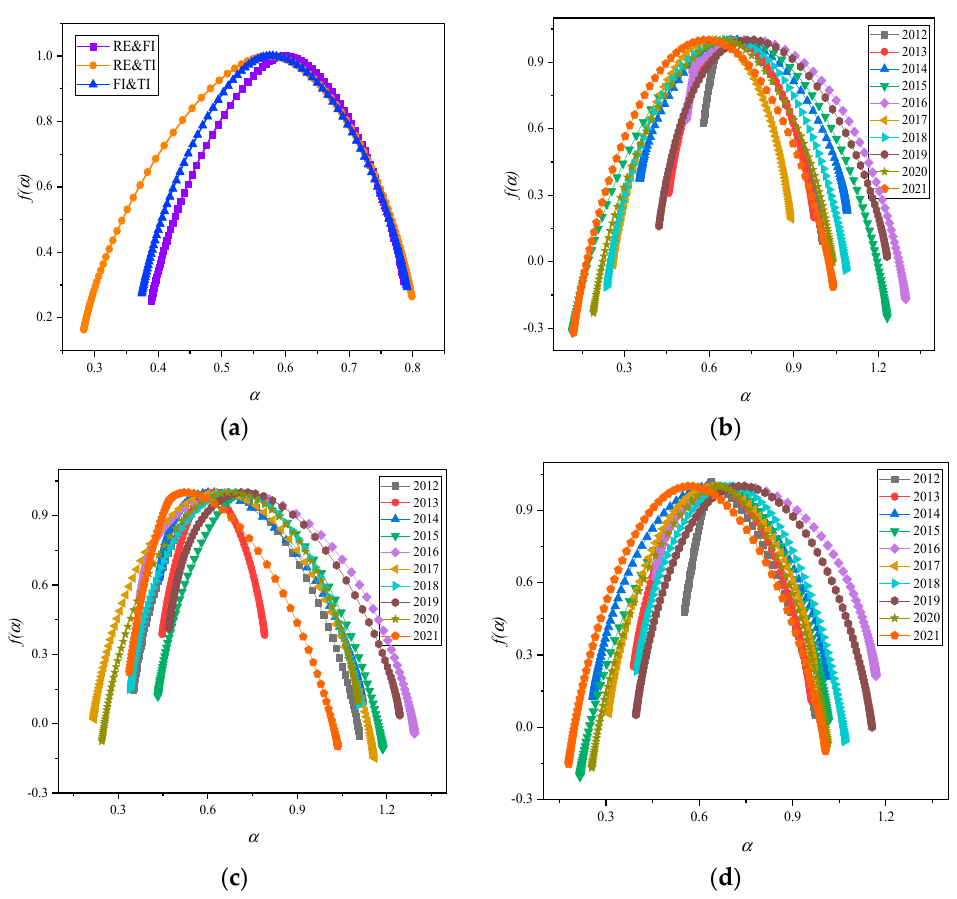
Figure 7. Multifractal spectrum among the TI, FI, and RE. ( a ) Overall sample. ( b ) Subsample RE and FI. ( c ) Subsample RE and TI. ( d ) Subsample FI and TI.